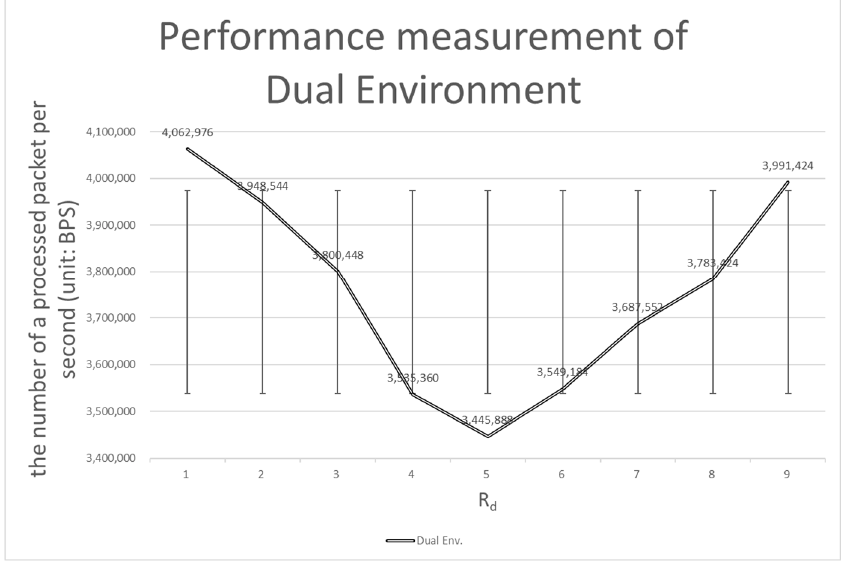
Figure 12. Performance measurement of the dual environment.